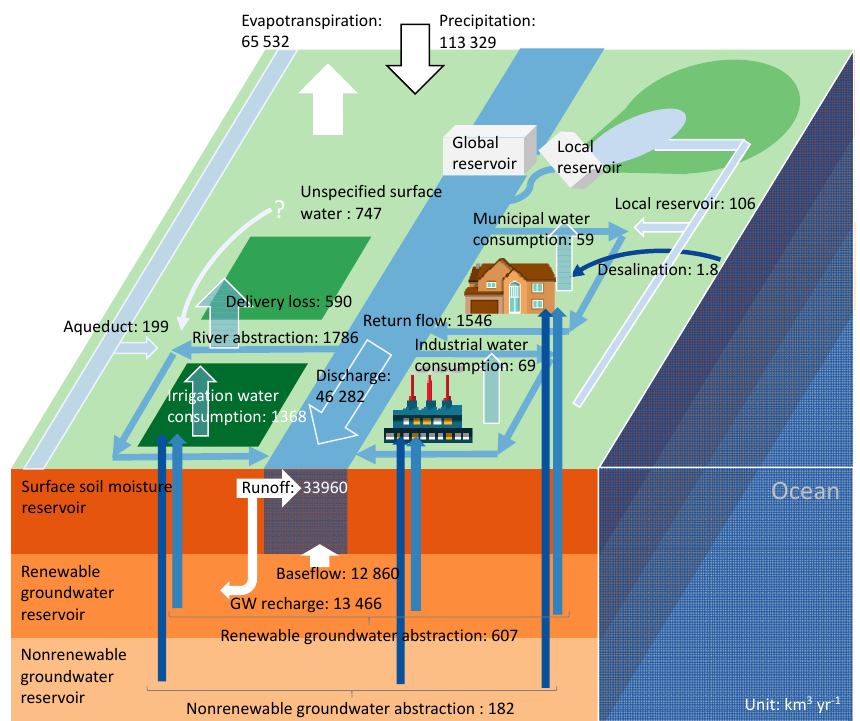
Figure 1. Schematic diagram of the water cycle and abstraction of the enhanced H08. Blue, green, and red symbols denote water, land, and underground reservoirs, respectively. The global reservoirs directly regulate the river flow, while the local reservoirs do not. The numbers are mean annual global water fluxes of key components.